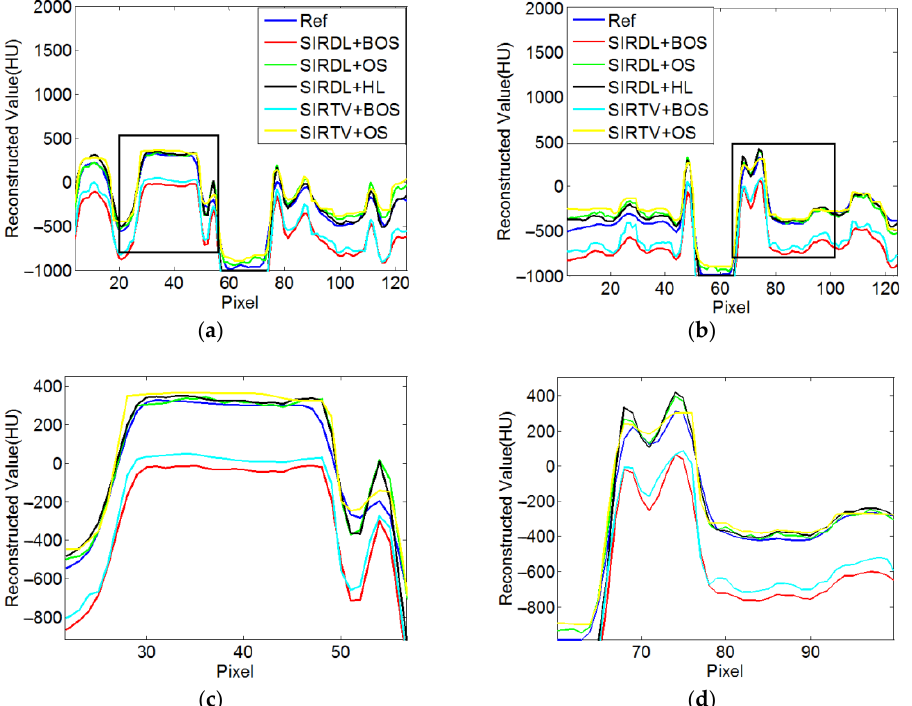
Figure 9. Profile plots of ROIs reconstructed from 1160 views in Figure 8: ( a ) Horizontal central line; ( b ) vertical central line; ( c ) local enlargement of rectangle in ( a ); ( d ) local enlargement of rectangle in ( b ).